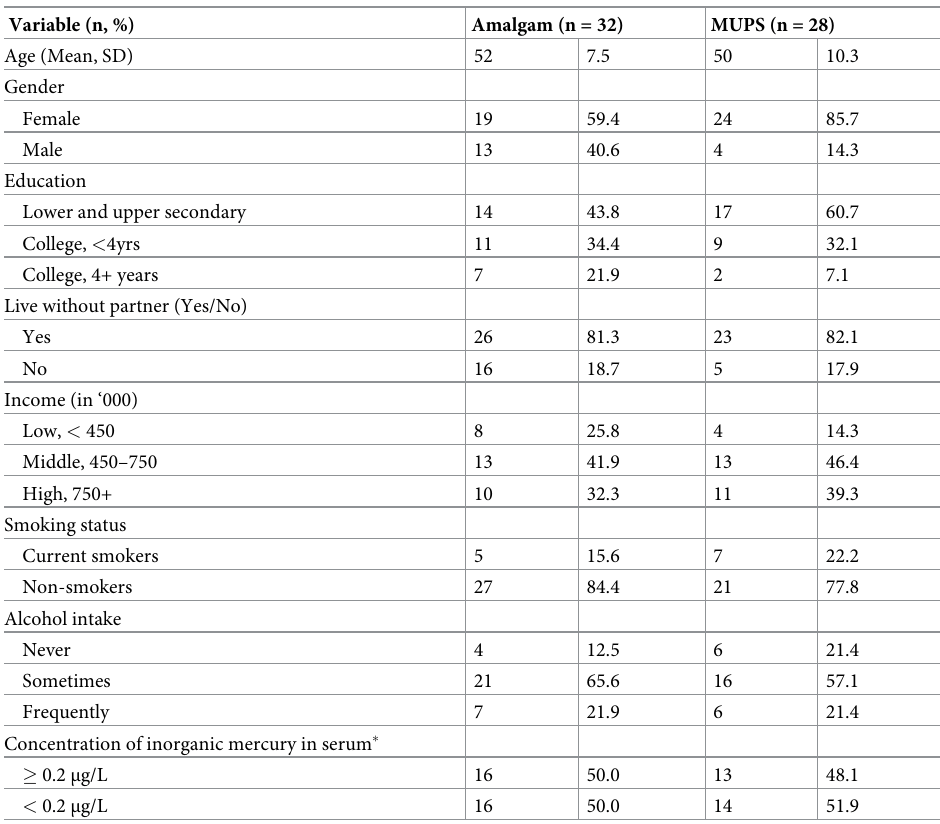
Table 1. Baseline